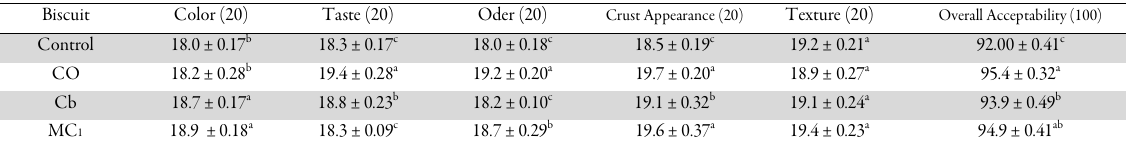
Table 13. Sensory evaluation of colored barley flour biscuit made using different levels of cocoa and chocolate brown